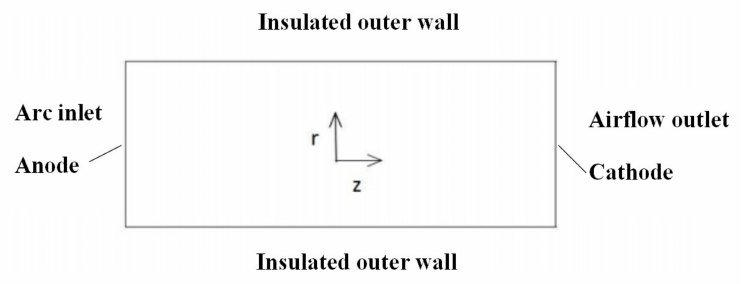
Figure 2. Simplified model of arc-quenching